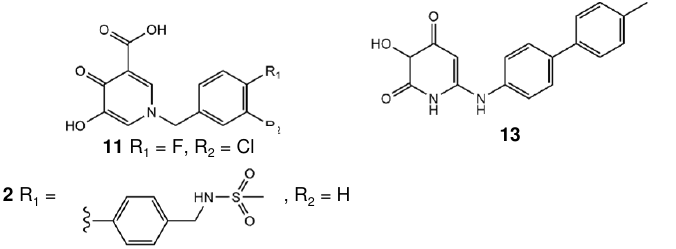
Figure 3. Structures of novel small molecule